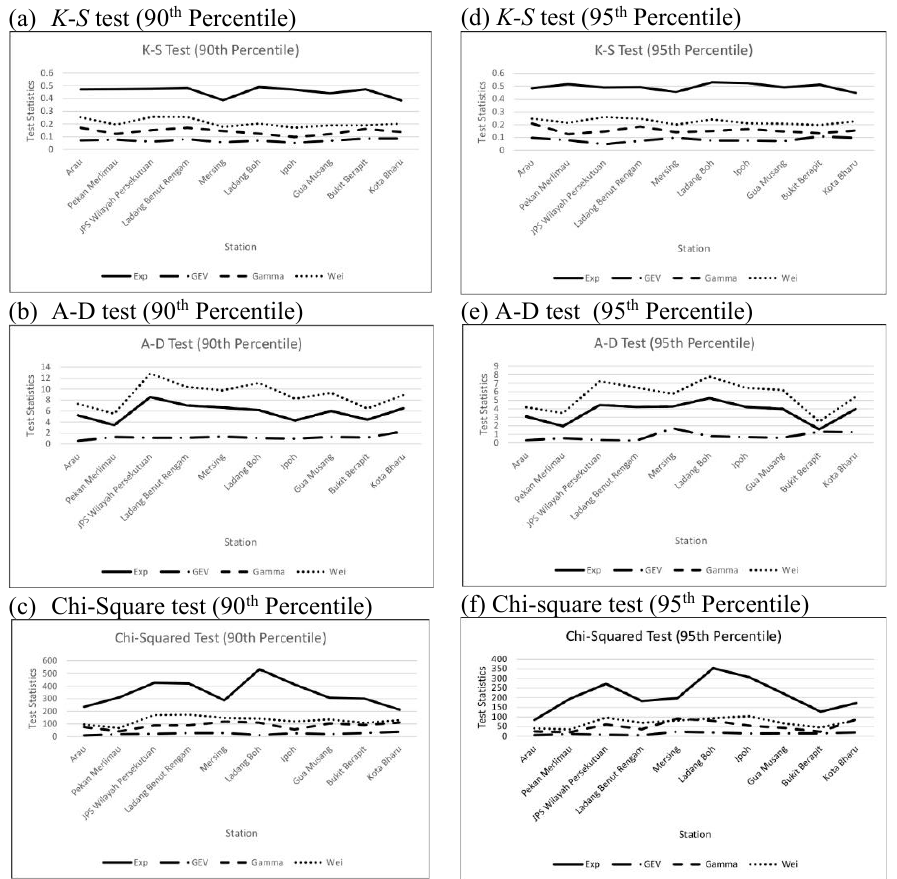
Fig. 1. Test statistics for (a)-(c) threshold value of 90 th percentile and (d)-(f) threshold value of 95 th